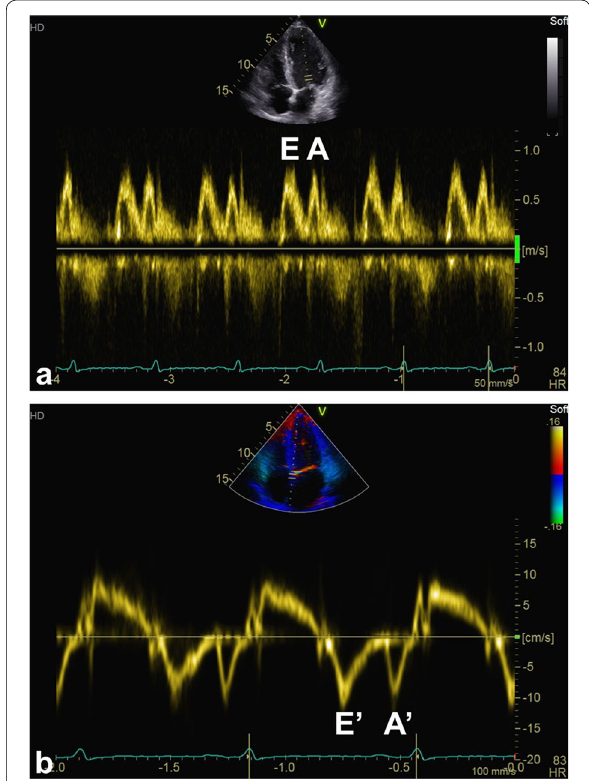
Fig. 2 Pulse wave Doppler and tissue Doppler. a Trans-mitralic Doppler; an early wave (E wave) is displayed on the monitor that represents the first phase of the diastole as a passive phenomenon, limited only by the stiffness of the left ventricle or by interventricular interdependence—right ventricular push over the left ventricle via the septum. The E wave in patient with sinus rhythm is followed by atrial contraction (A wave). b Septal tissue Doppler; tissue Doppler directly measures myocardial velocities by means of the E ʹ wave in a load-independent way. The combination of the trans-mitral Doppler E wave, the tissue Doppler E ʹ wave, and the E / E ʹ ratio at the end of an SBT also seems to be capable of predicting weaning failure from diastolic